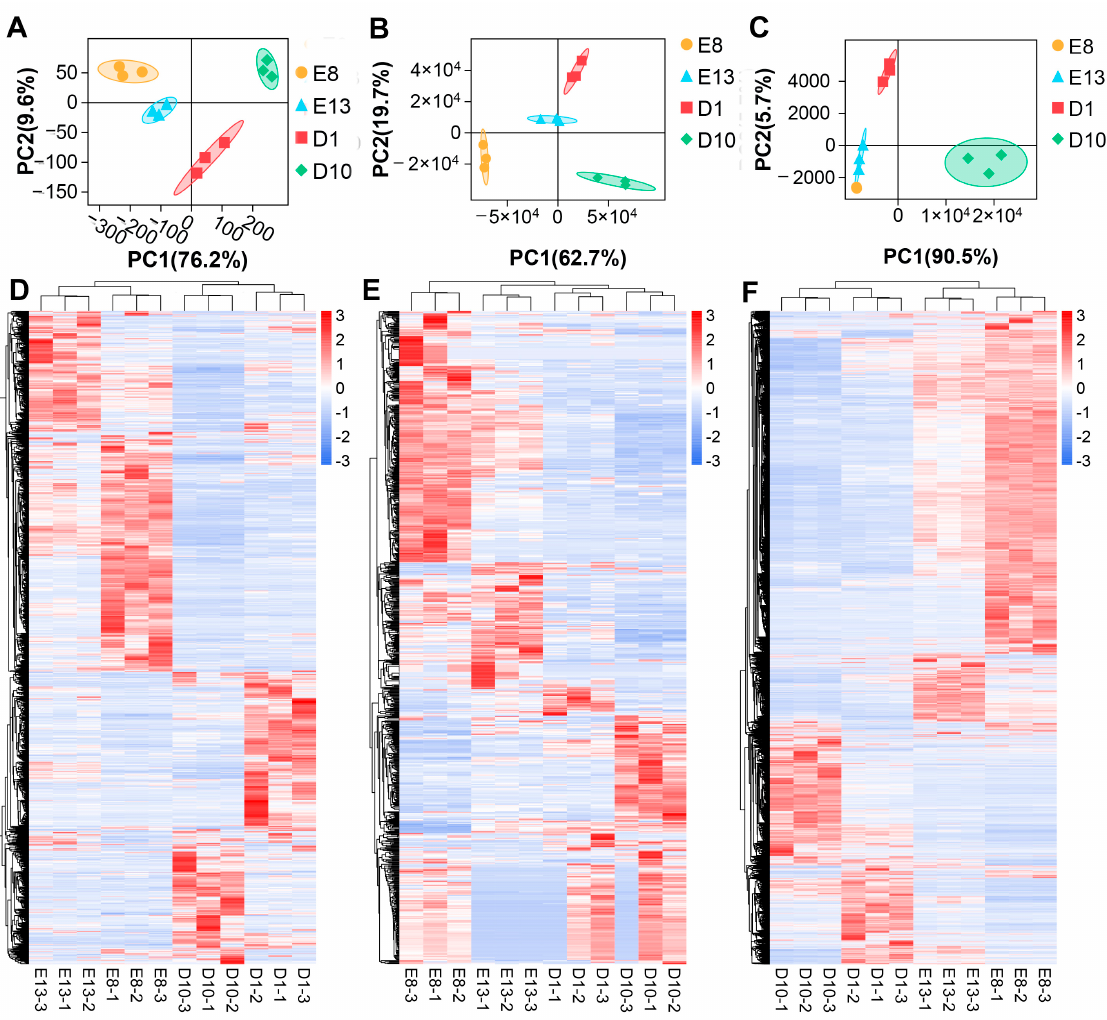
Figure 2. Identification of DE lncRNAs, miRNAs, and mRNAs during pigeon skeletal muscle development: ( A ) PCA plot of all lncRNAs expressed in pigeon skeletal muscle samples; ( B ) PCA plot of all miRNAs expressed in pigeon skeletal muscle samples; ( C ) PCA plot of all mRNAs expressed in pigeon skeletal muscle samples; ( D ) hierarchical clustering heatmap of all the DE lncRNAs; ( E ) hierarchical clustering heatmap of all the DE miRNAs; ( F ) hierarchical clustering heatmap of all the DE mRNAs. Both PCA and hierarchical clustering results demonstrate excellent repeatability of the samples.